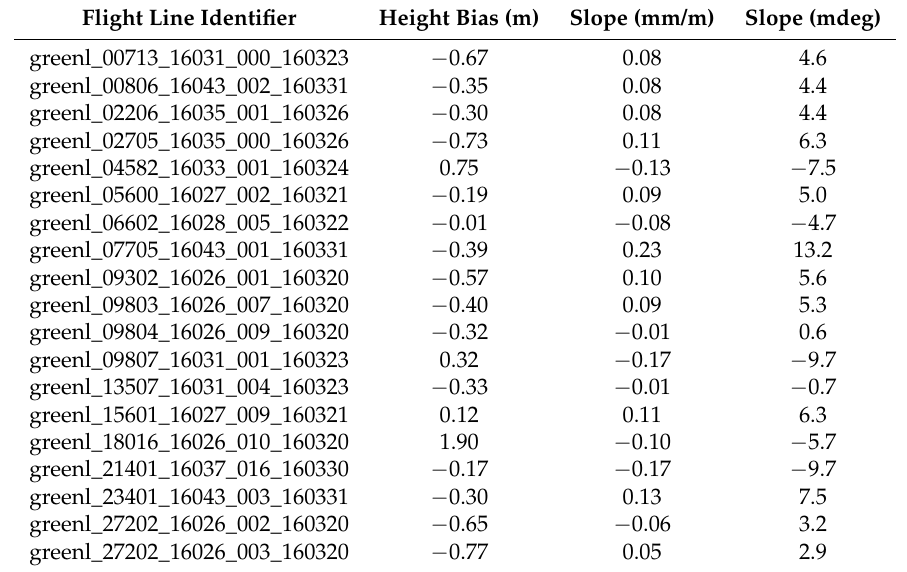
Table A1. Summary of 2016 lines validated with ATM data summarizing residual linear trends (GLISTIN-ATM).